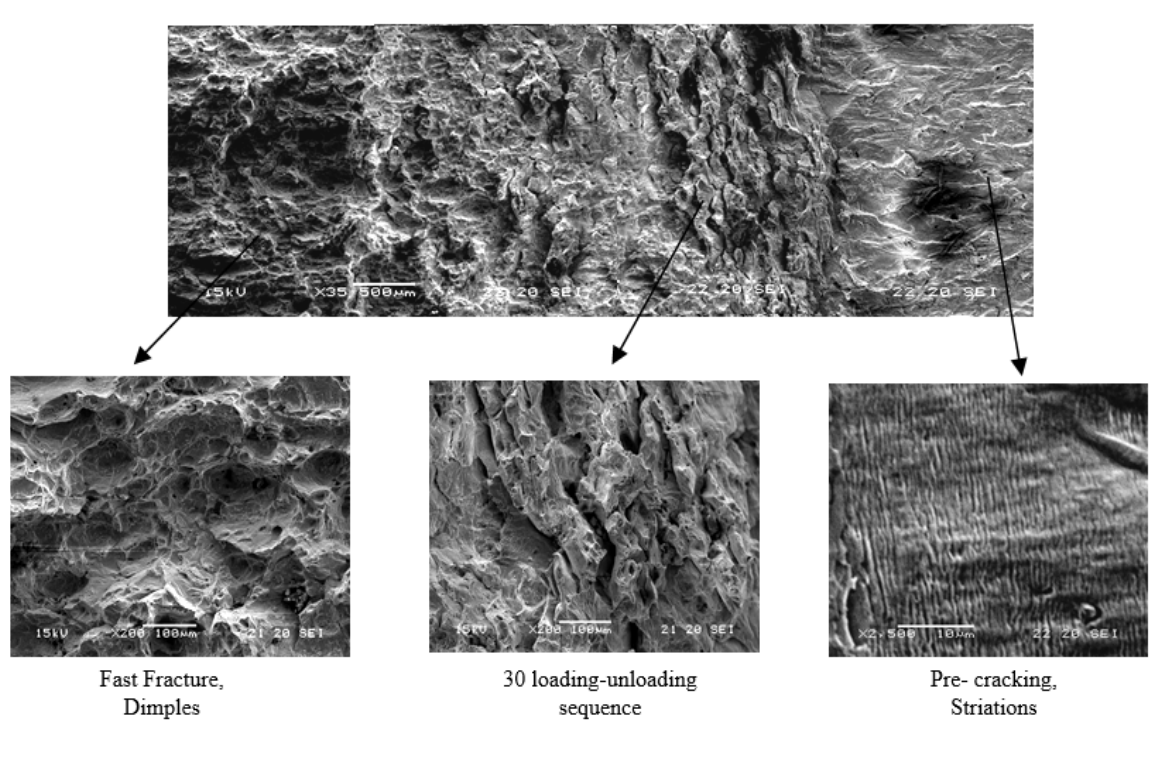
Figure 15: SEM micrographs of sampled